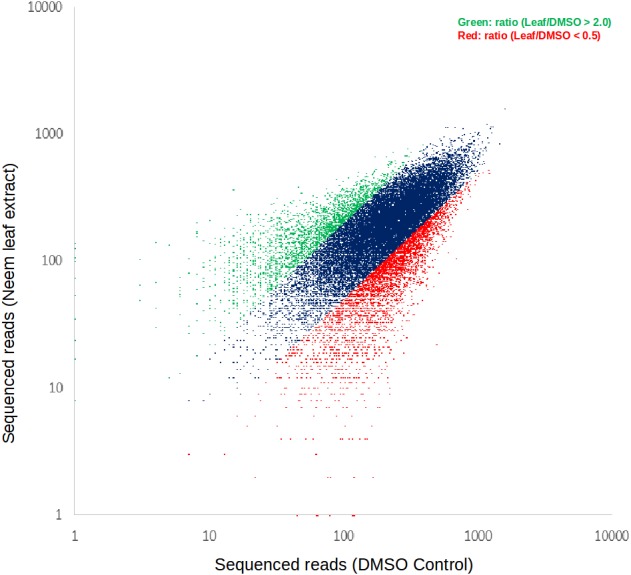
Scatter plot for barcodes in the sequencing reads in treated vs. control neem leaf extract.